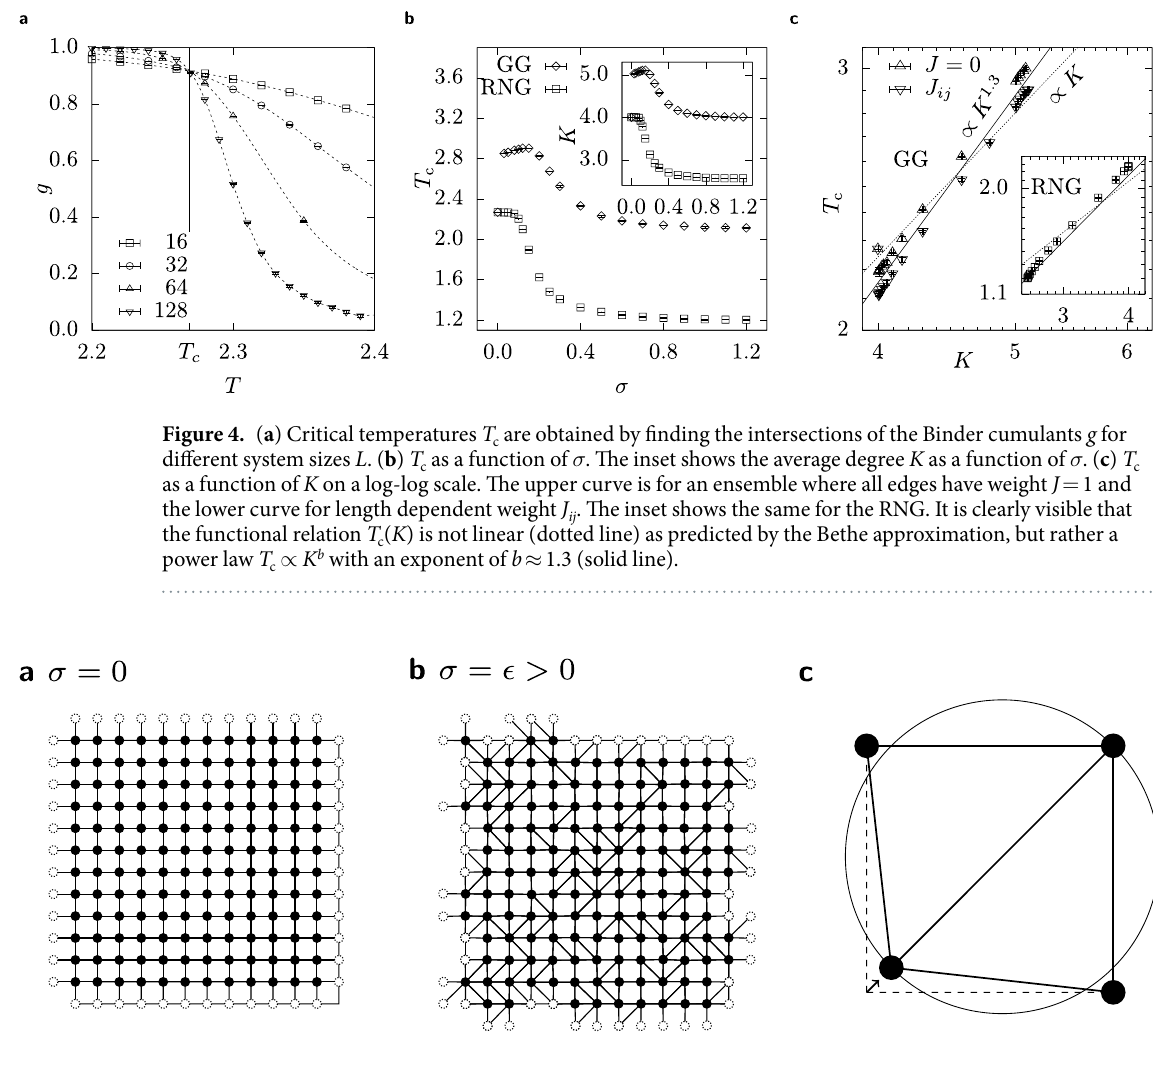
Figure 5. Visualisation of the occurence of the jump at small values of σ for the GG. ( a ) The regular lattice with no disorder. ( b ) Example of a graph for a very small value of the disorder. ( c ) Sketch of a GG with N = 4 nodes for very small σ . Due to the construction rule of the GG a new edge appears resulting in a jump in K and T c , see Fig. 4b. This does not occur in the